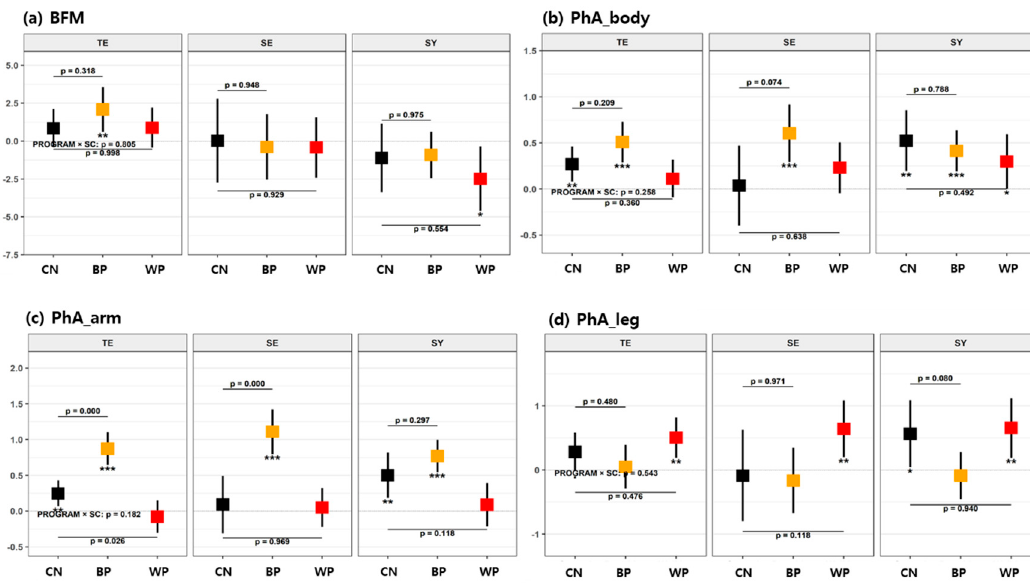
Figure 4. Mean changes in bioimpedance variables after each of the FTPs according to SC types for ( a ) body fat mass (BFM), ( b ) PhA_body, ( c ) PhA_arm, and ( d ) PhA_leg. The details are identical to those in Figure 3.